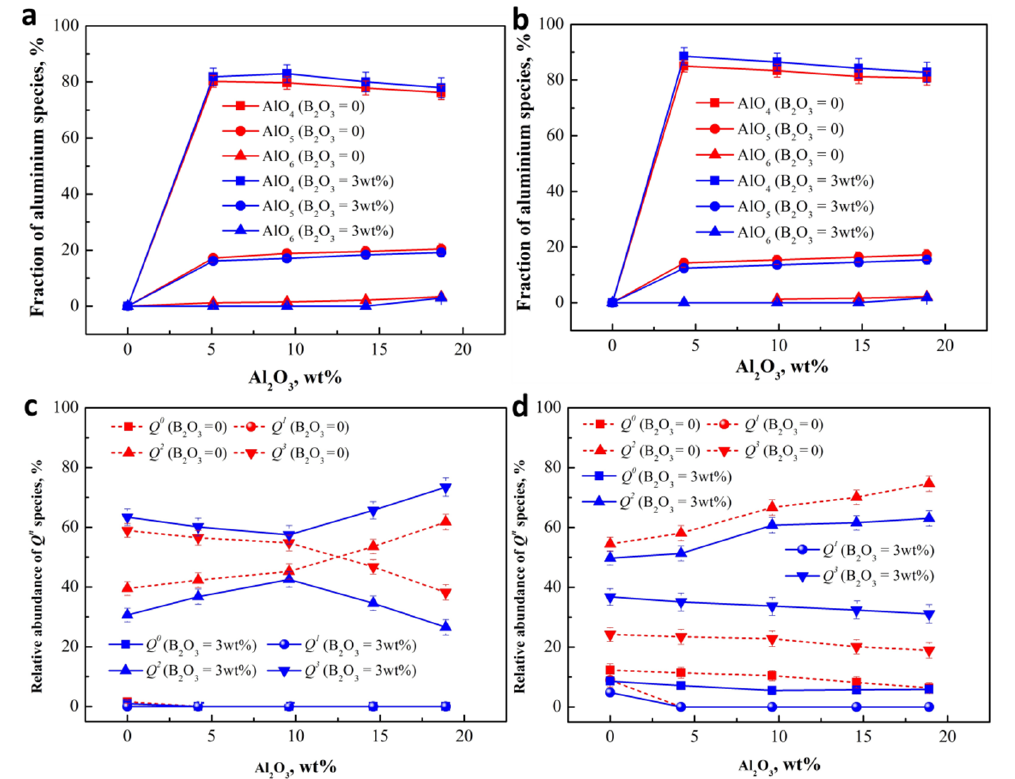
Figure 7. Fraction of Al species as a function of basicity and Al 2 O 3 contents based on 27 Al MAS NMR of the CaO-SiO 2 -Al 2 O 3 slag at 0.6 of basicity ( a ) and 1.1 of basicity ( b ). Distribution of Q n speciation as a function of Al 2 O 3 contents based on Raman spectroscopy of the CaO-SiO 2 -Al 2 O 3 slag at 0.6 of basicity ( c ) and 1.1 of basicity ( d